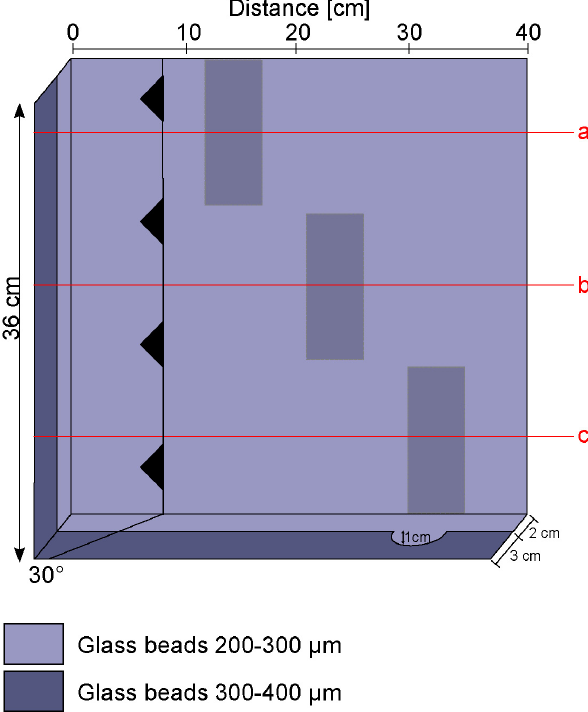
Fig. 7. Setup of the channel model consisting of two glass-bead layers. While a shear zone of 30 ◦ dip angle is prepared close to the left side of the analogue model, a channel structure is distributed over three positions in the model. Lines a–c mark locations of the seismic sections shown in Fig.